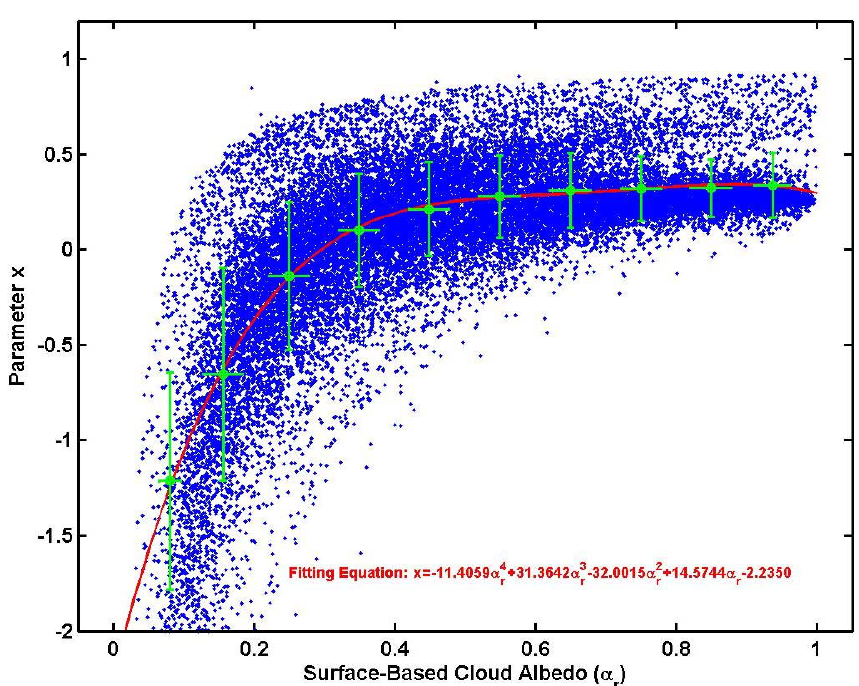
Fig. 9. The parameter x as a function of surface-based cloud albedo. The red curve is the fit as described by the equation; the green dot and vertical lines are the average and corresponding ± standard deviation, respectively. The data points with x < − 2 are discarded in the analysis due to their rare and unphysical occurrences.